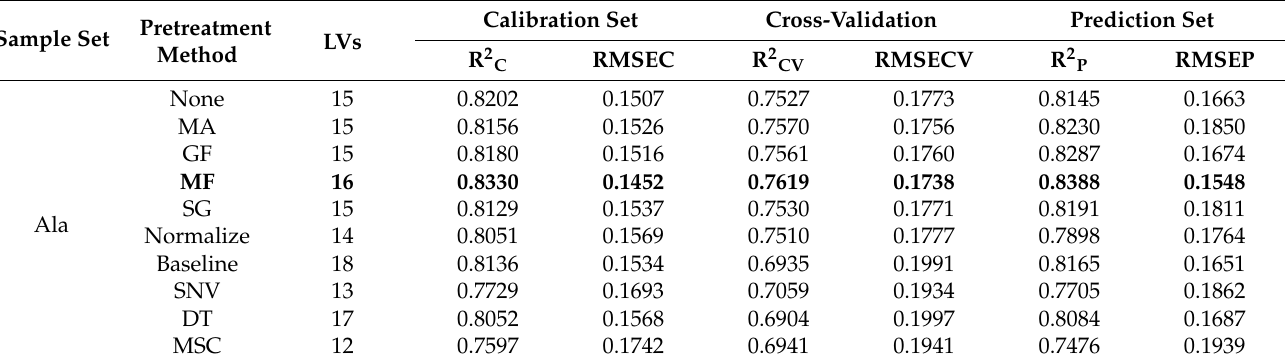
Table 4. PLSR model performance of different pretreatment